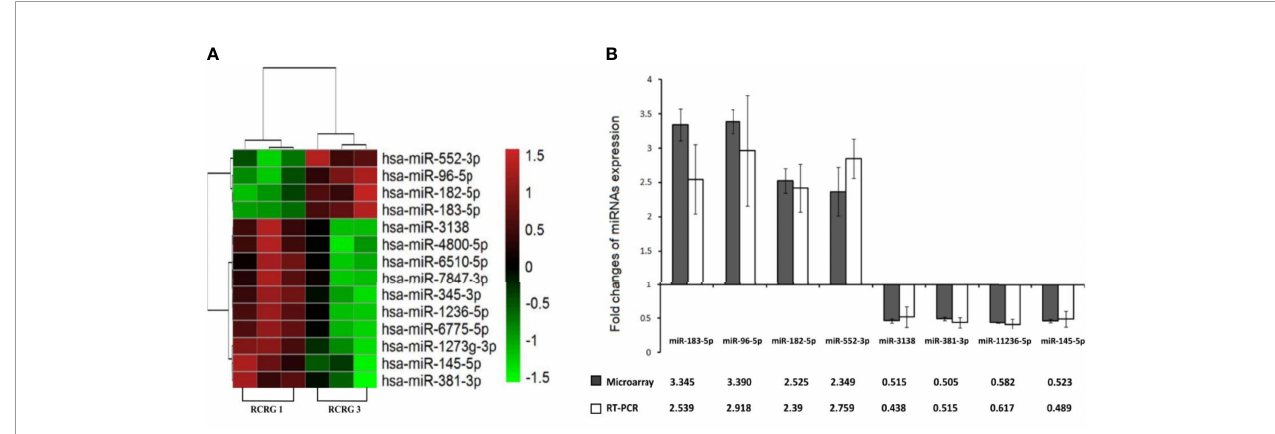
FIGURE 3 | Differential miRNAs expression between RCRG1 and RCRG3. (A) MiRNAs microarray was used to detect the differential expression of miRNAs between RCRG1 and RCRG3, the scale bar indicates miRNAs expression level: red represented high expression, green represented low expression; (B) Differential expression miRNAs were con fi rmed by qRT-PCR.